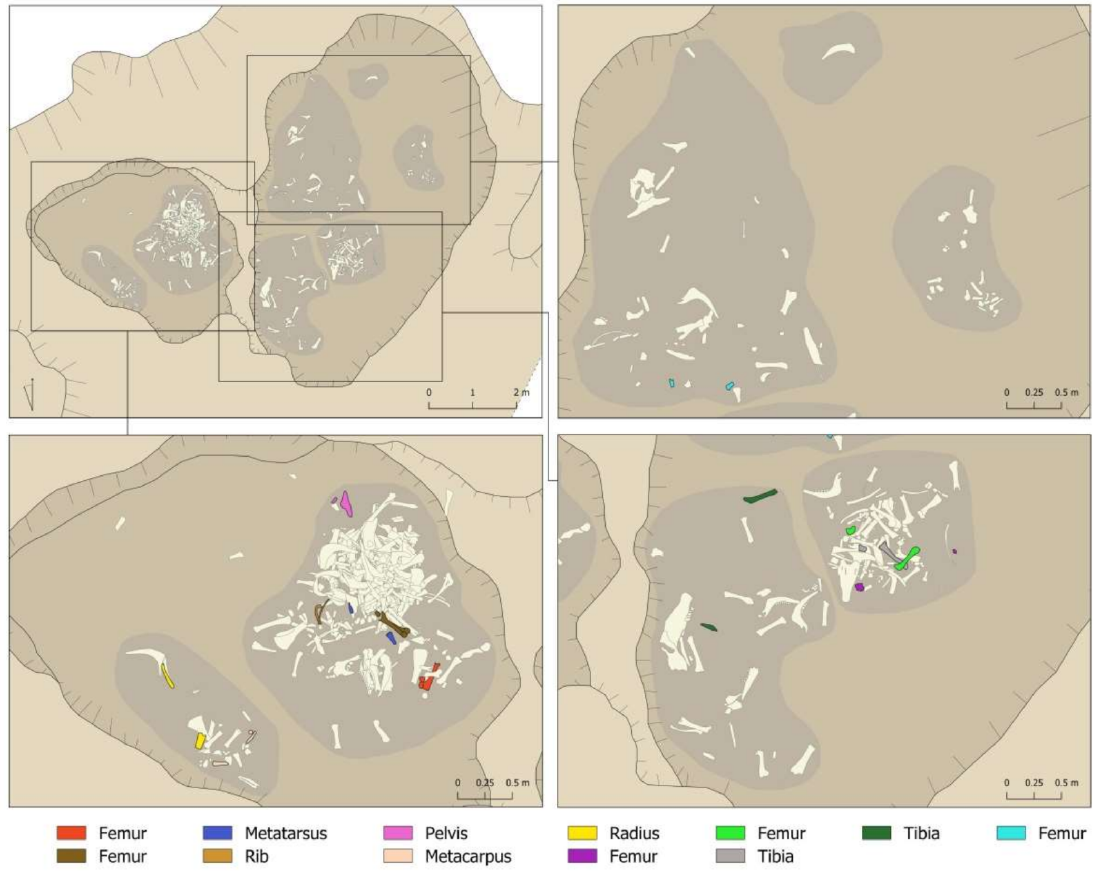
Figure 7. Reassemblages documented in Layer 1 of the different areas of the Vilauba